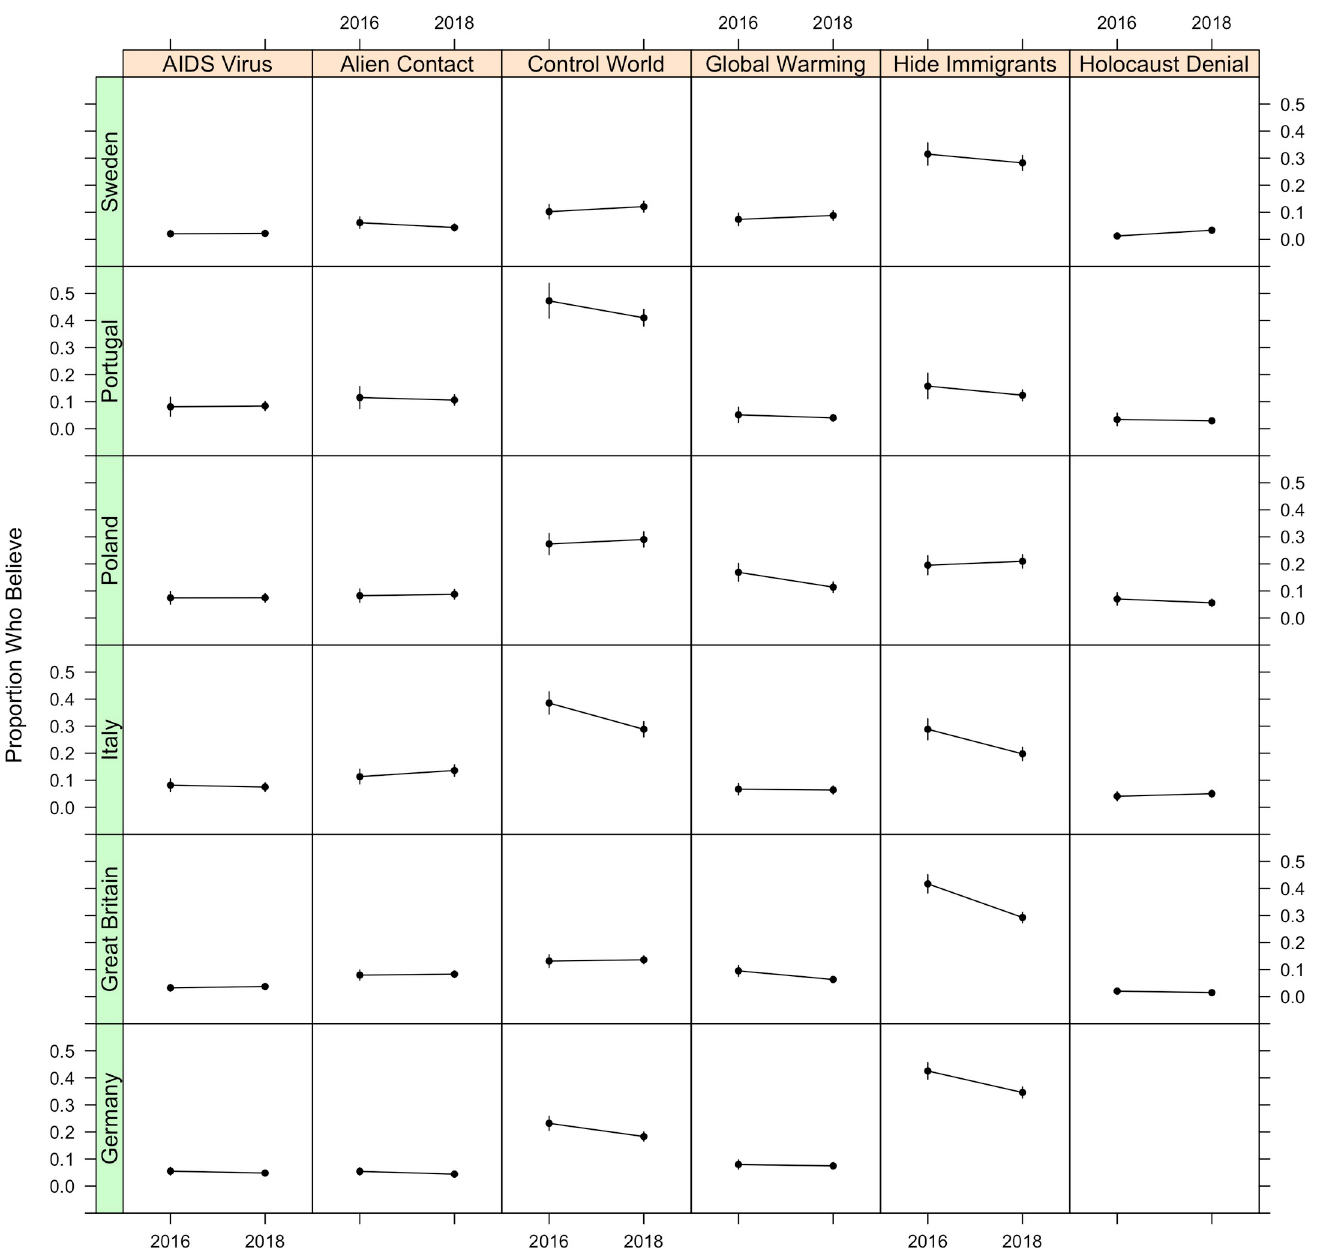
Fig 2. Proportion of adults across 6 European countries who express agreement with each conspiratorial sentiment over time.